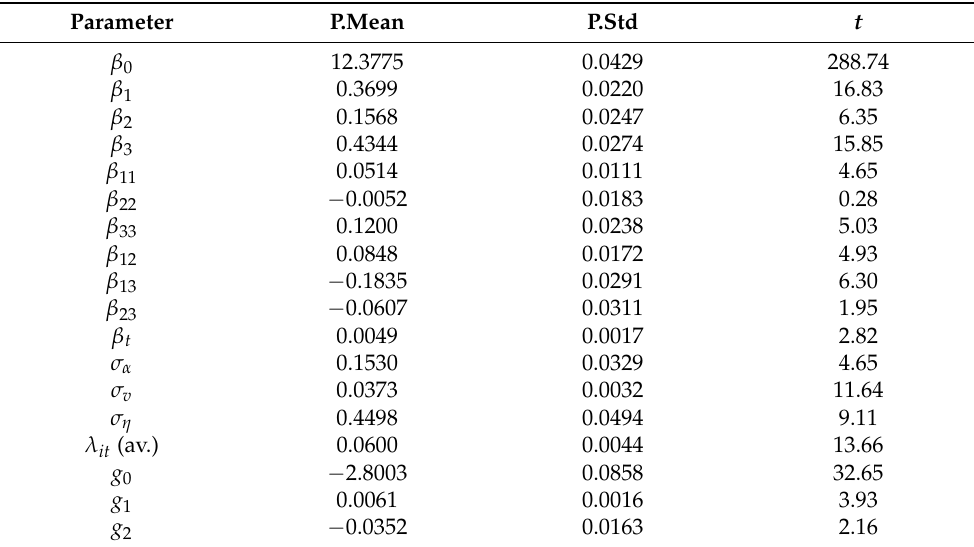
Table 2. Results based on the model with TPES (Equation